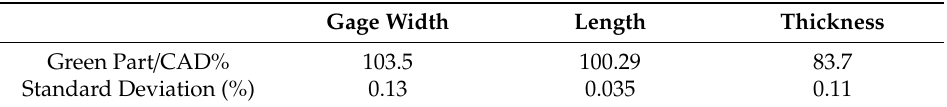
Table 1. The dimensional deviation of the green samples from the CAD model. p = 5.36 W; spot size